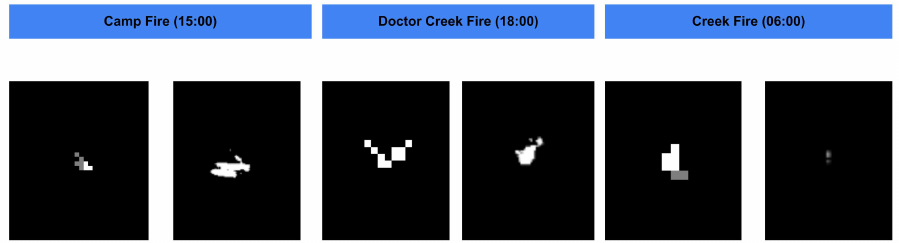
Figure 15. Emerging stage of the wildfire at three study areas and its capture